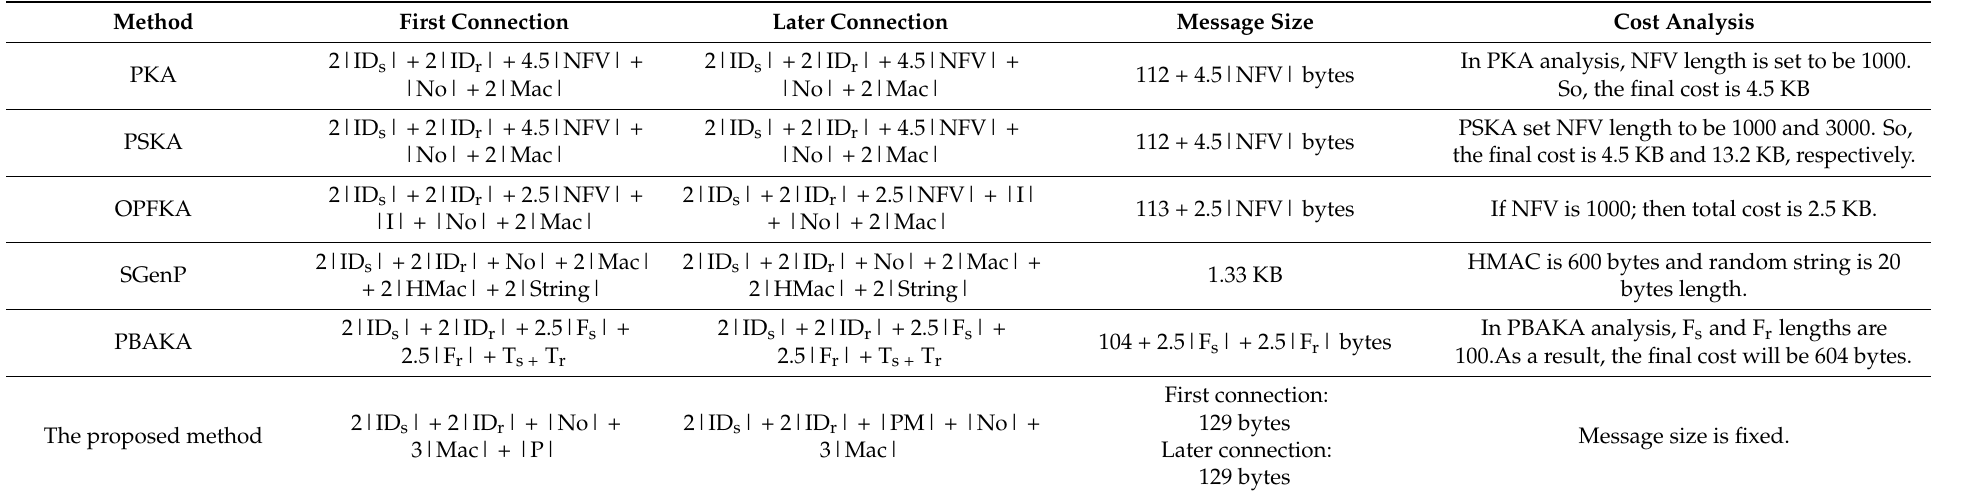
Table 6. Communication overhead for first/later